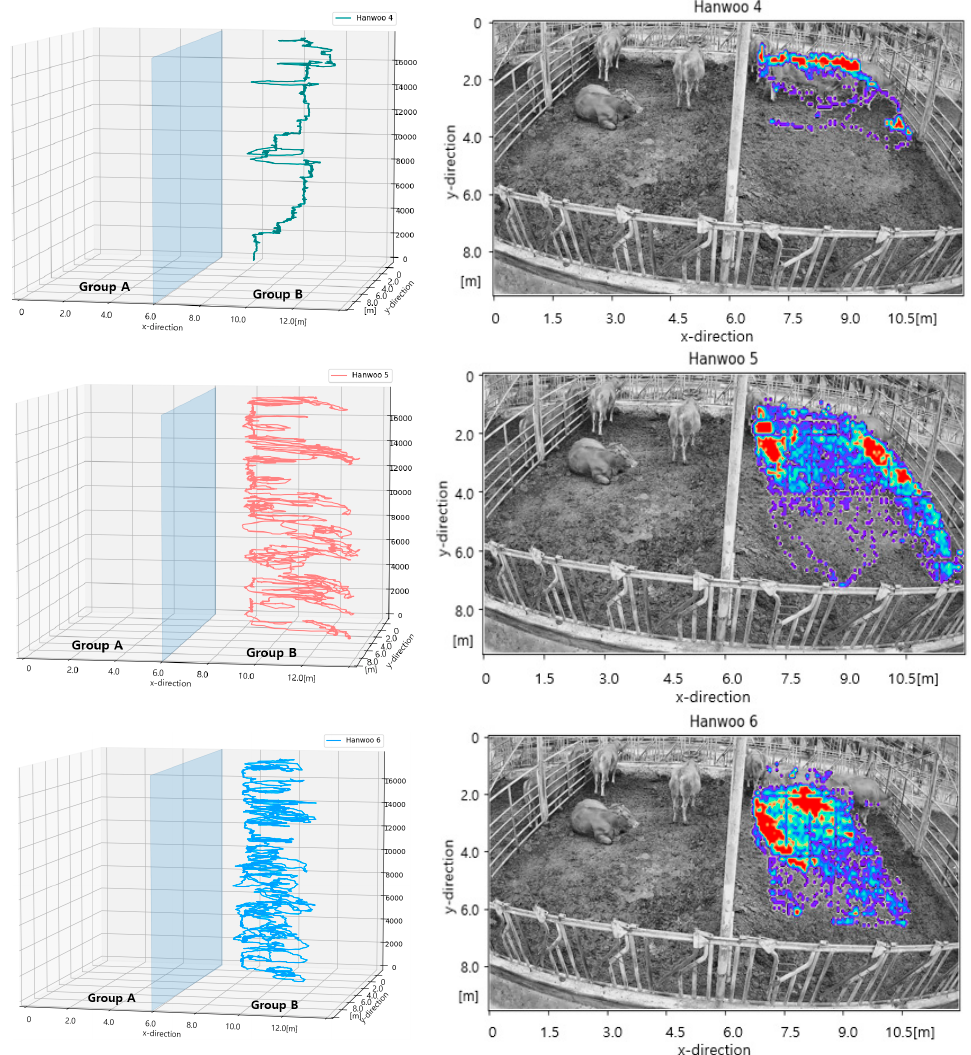
Figure A1. Time series pathway and staying graph through the tracking of target Hanwoo objects for the utilization of data analysis.